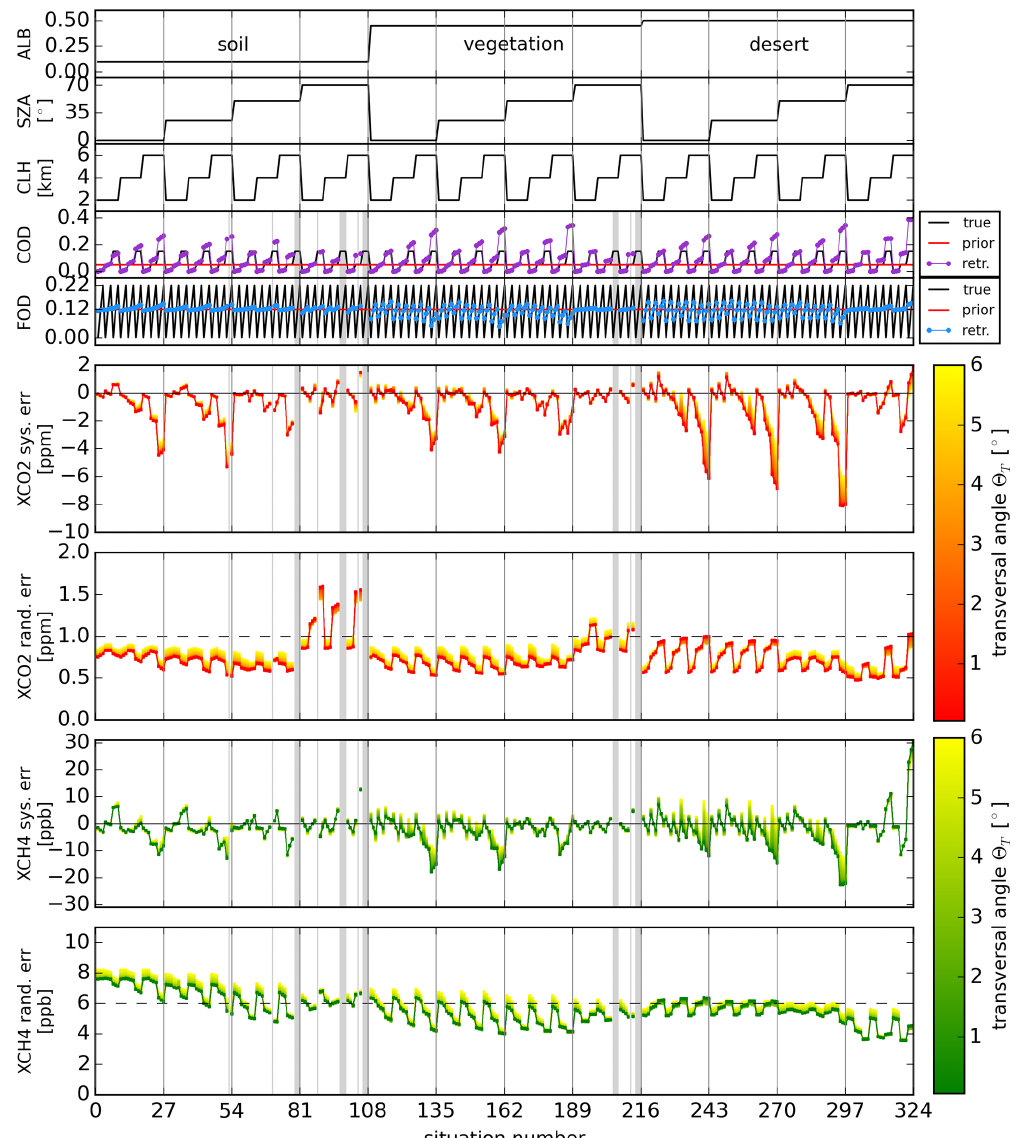
Figure 9. NanoCarb systematic and random errors for X CO and X CH in the no-SPEX design scenario case. Results are plotted as a function 2 4 of the situation number: the five top panels detail the ALB (0.7µm), SZA, CLH, COD and FOD values defining all 324 situations. In addition, the a priori and averaged retrieved COD and FOD values are also shown in the fourth and fifth top panels. The sixth and seventh panels show X CO systematic and random errors, respectively, and the eighth and ninth panels show X CH systematic and random errors, respectively. 2 4 The dependence on the transversal angle θ T of L2 results is shown with the colour scales: darker colours correspond to lower θ T absolute values. Grey-shaded areas denote situations for which retrievals did not satisfactorily